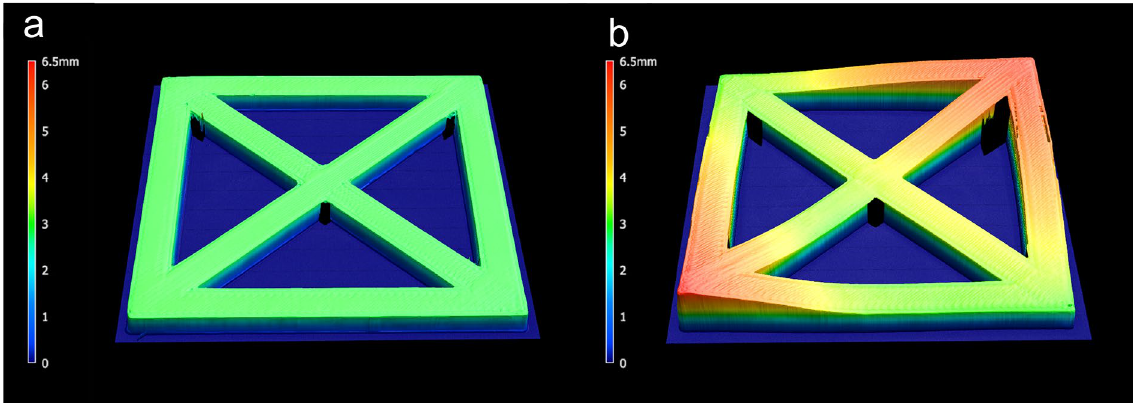
Figure 2. Scan of a test specimen (group R) after 3D printing ( a ) and after steam sterilization ( b ). The color map indicates the height of the specimen. The volume of the original STL file was subtracted from the volume of the scans to determine the respective deviation.